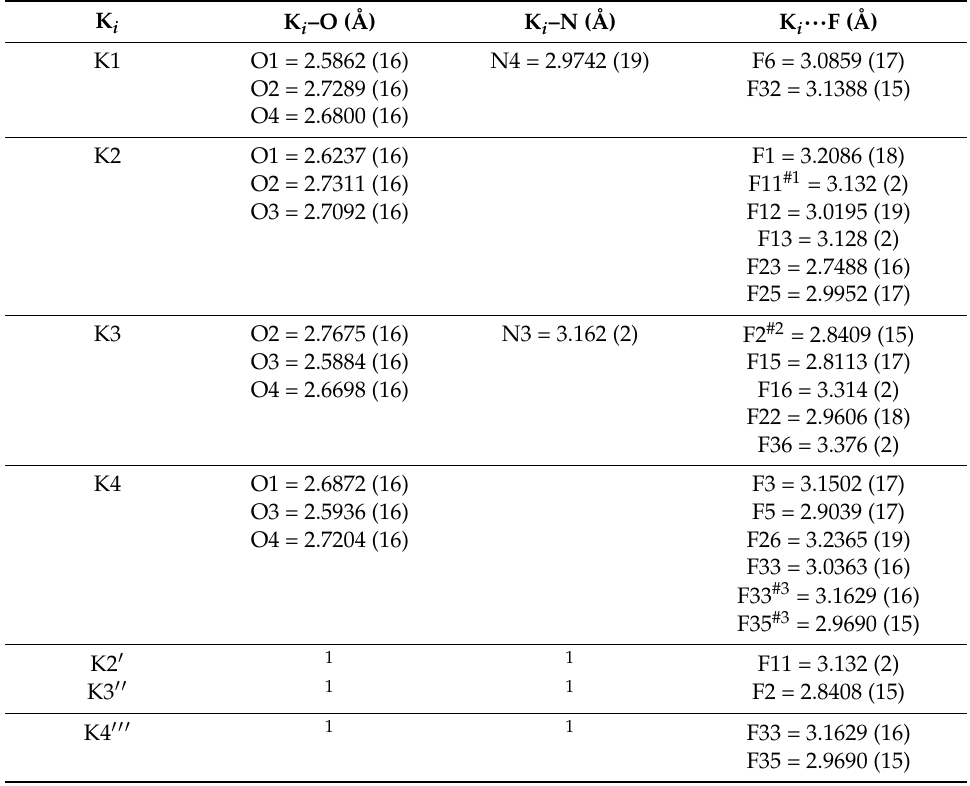
Table 4. Key metric parameters in the potassium complex [{RO 4 }K] 4 ([ 4 ] 4